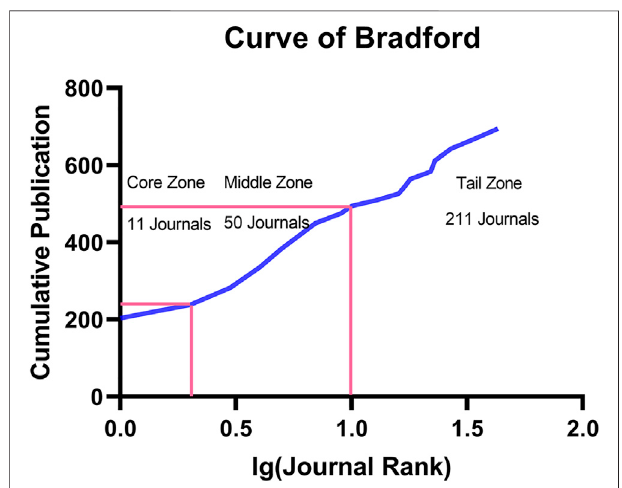
FIGURE 5 | Bradford